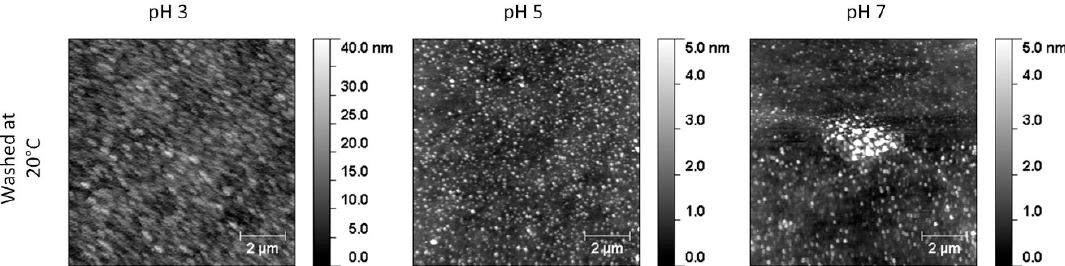
Figure 8. AFM images of IPN films spin-coated on glass-OH at 5000 rpm from a dispersion of 3 wt%, after being washed in water at 20 °C and pH equal to 3, 5, and 7.